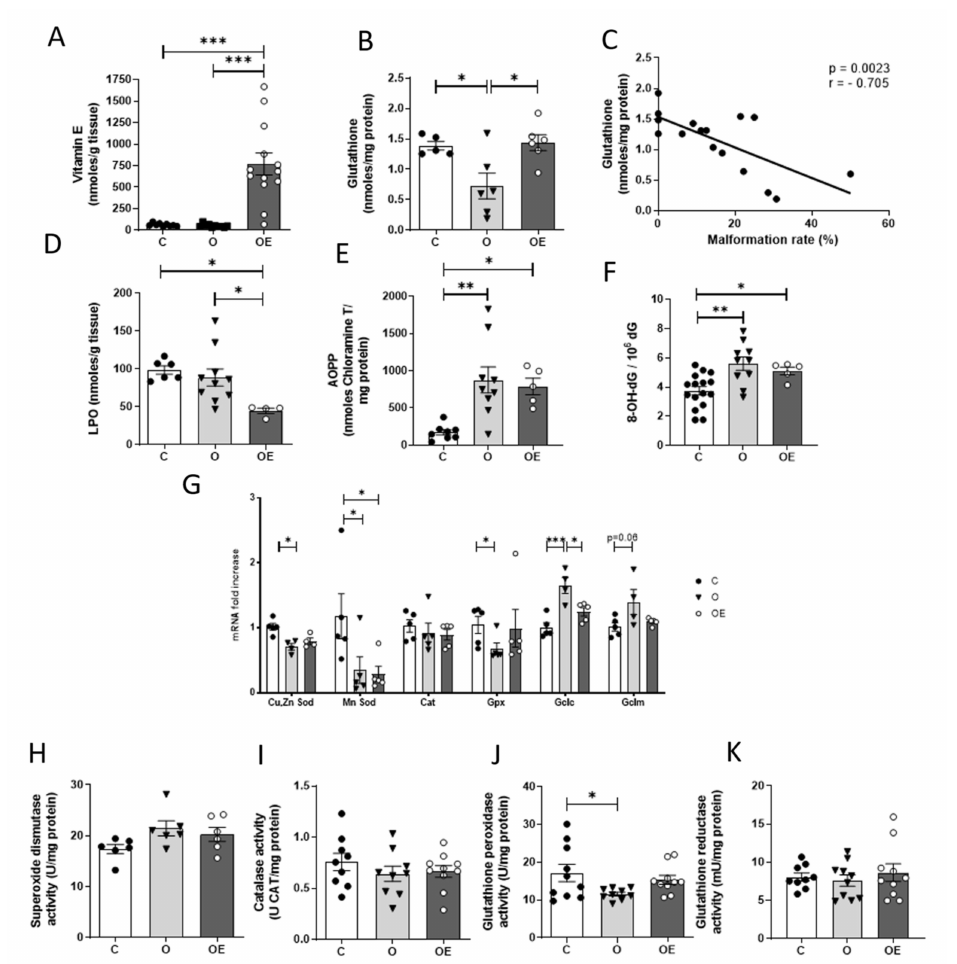
Figure 3. Cafeteria diet induces oxidative stress in the livers of obese, pregnant rats. Non-enzymatic antioxidants were determined in the livers of the pregnant rats: ( A ) vitamin E and ( B ) total glutathione. ( C ) Correlation between maternal liver total glutathione content and embryo malformation rate. Oxidative damage was analyzed through the quantification of oxidation end-products: ( D ) Hepatic lipoperoxides, ( E ) Advanced oxidation protein products (AOPPs), ( F ) 8-hydroxy- deoxyguanosine levels, as a marker of oxidative damage to DNA. ( G ) qPCR assays were performed of genes encoding free radical scavenging enzymes: Cu, ZnSod, MnSod, Cat, Gpx, Gclm and Gclc . Expression values represent 5 biological replicates and are shown relative to Tbp expression as a housekeeping gene. Activity assays of the antioxidant enzymes, superoxide dismutase ( H ), catalase ( I ), glutathione peroxidase ( J ) and glutathione reductase ( K ). Results are represented as mean + SEM. * p < 0.05; ** p < 0.01 *** p < 0.001. C: Black circles; O: Black triangles; OE: white